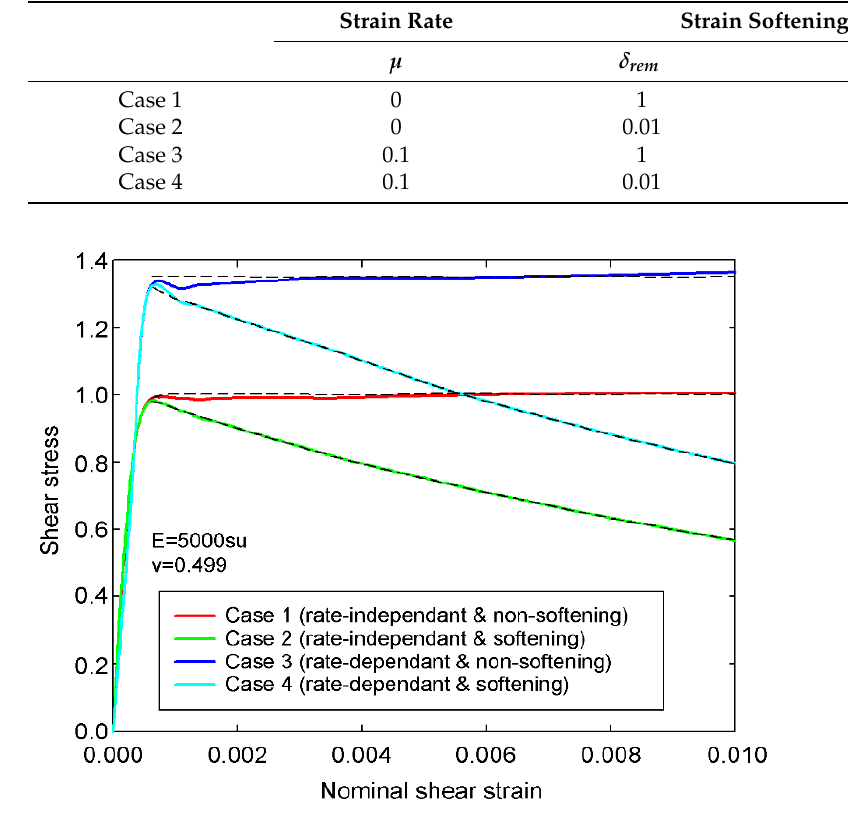
Figure 5. Verification results.